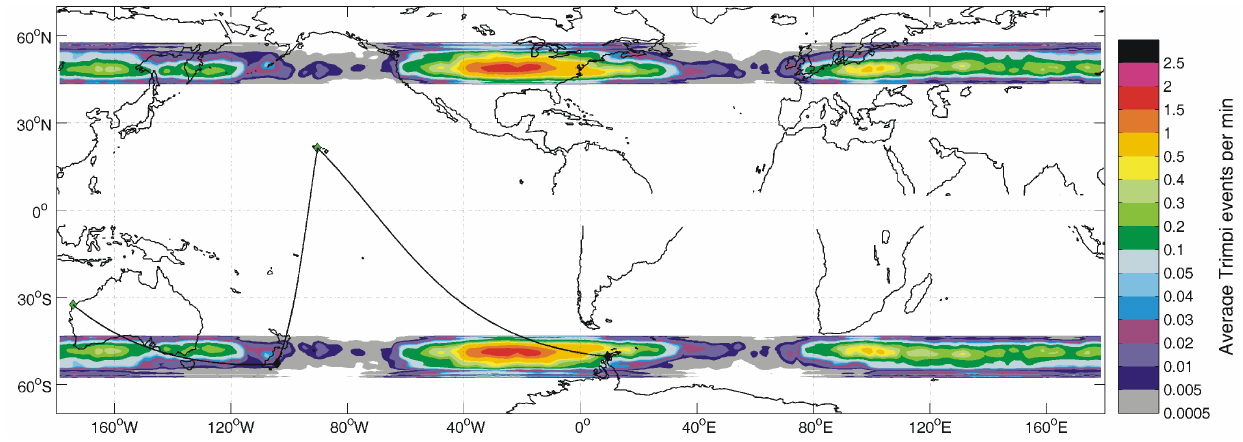
Fig. 3. Map showing the expected global distribution in the rate of WEP producing Trimpi in CGM coordinates. The Great Circle Paths from the transmitters (green diamonds) to the receivers (black diamonds) considered in our study are also shown.